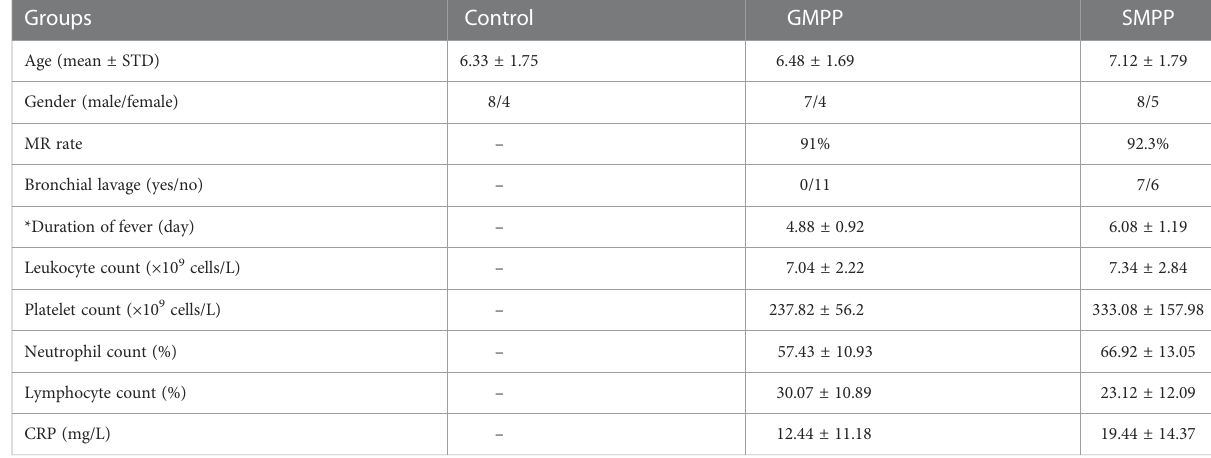
TABLE 1 General information of the participants: Statistical differences between GMPP and SMPP groups were marked with * on item names.